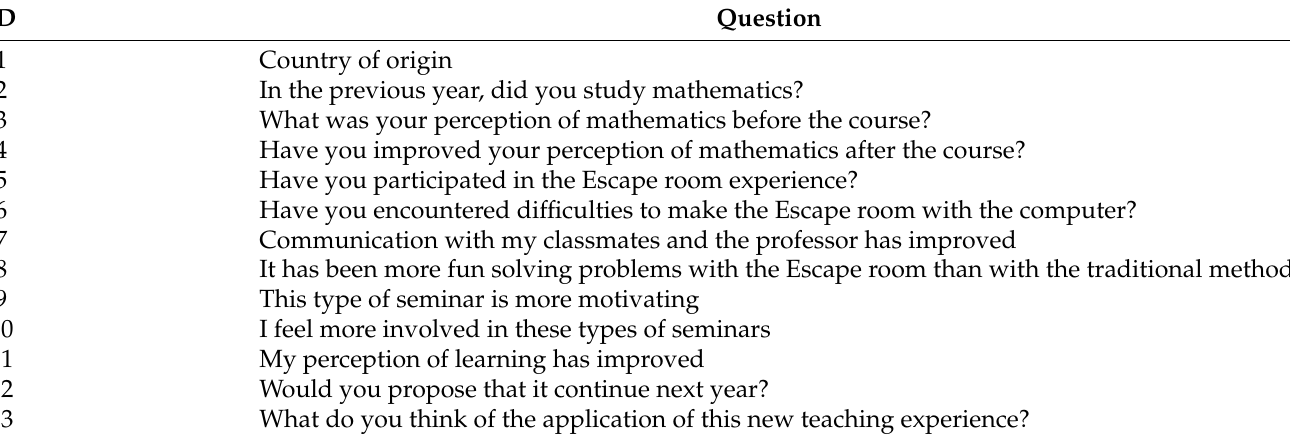
Table 8. Questions asked in the questionnaire for the students.